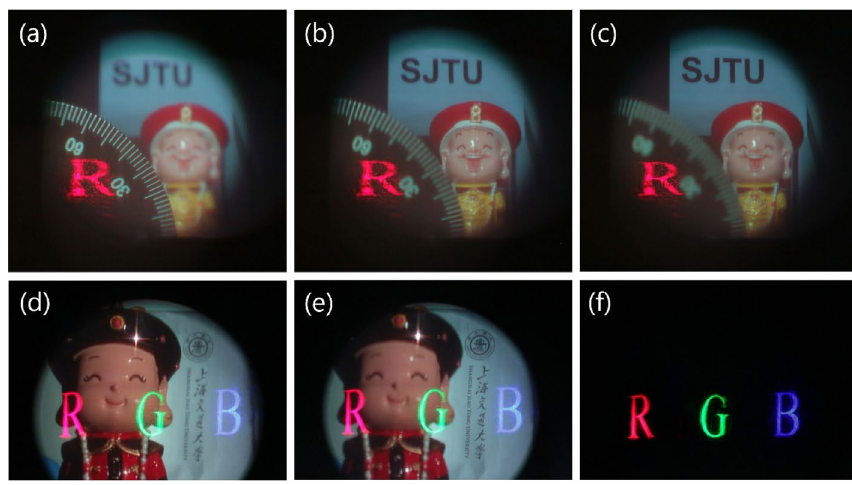
Fig. 7 Imaging results of the metalens‑visor. ( a to c ) Demonstration of single‑color AR imaging under red (633 nm) laser illumination. The images are focused at ( a ) 150 mm (dial), ( b ) 600 mm (puppet) and ( c ) 2000 mm (“SJTU”), respectively. ( d, e ) Demonstration of multi‑color AR and ( f ) corresponding VR imaging under red (633 nm), green (532 nm) and blue (457 nm) laser illumination. The images are focused at ( d ) 200 mm (puppet) and ( e ) 1200 mm (logo and texts), respectively. The real objects will become blurry or